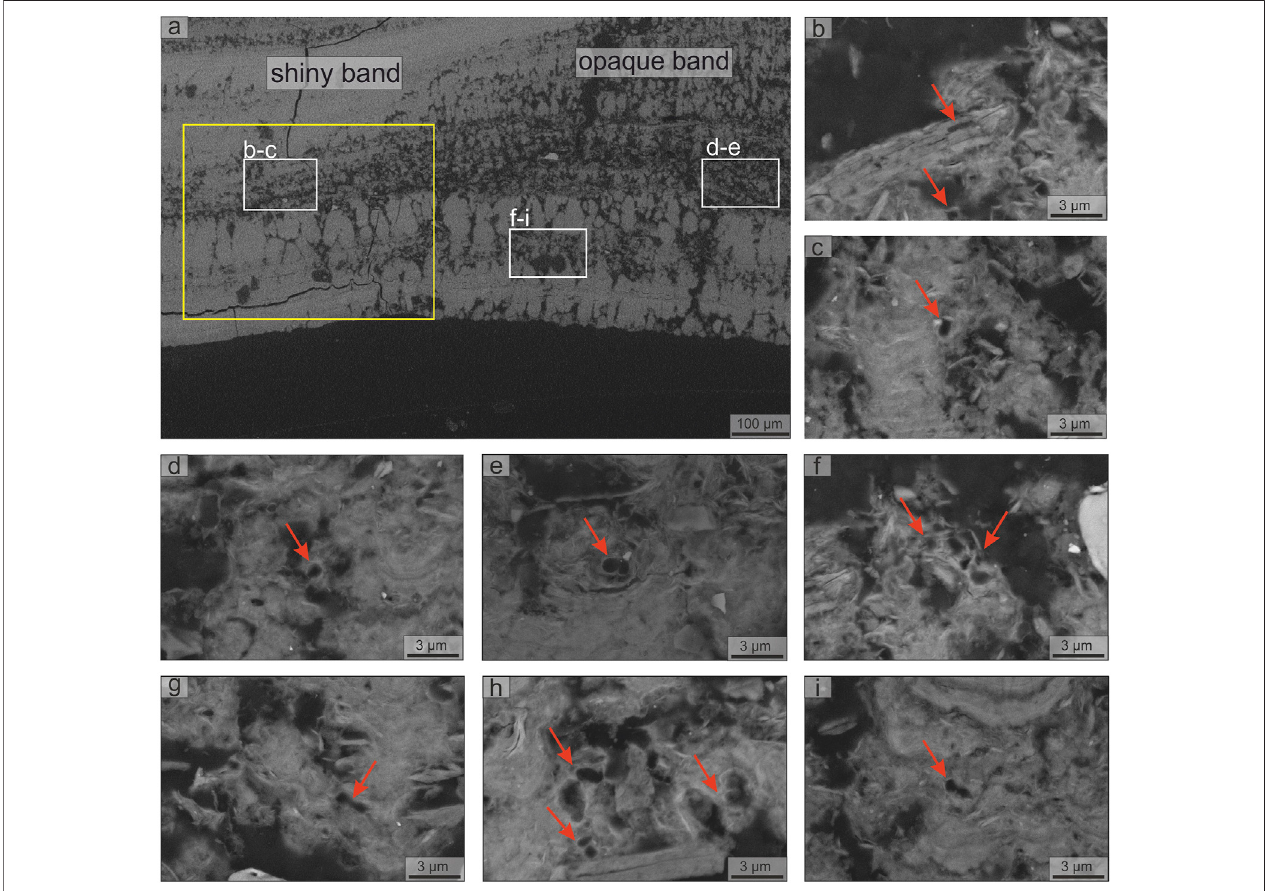
FIGURE 11 | SEM-EDS investigation of polished cross-section of the Fe-Mn patinas (sample GC): (A) areas of investigation, white boxes indicate the positions of other panels, yellow box indicate the position of the Raman map ( Figure 7 ), (B – I) bacterial microbial imprint (red arrows). Putative predivisional cell stages typical of staked bacteria are showed in panels (E) , (G) , and (I)